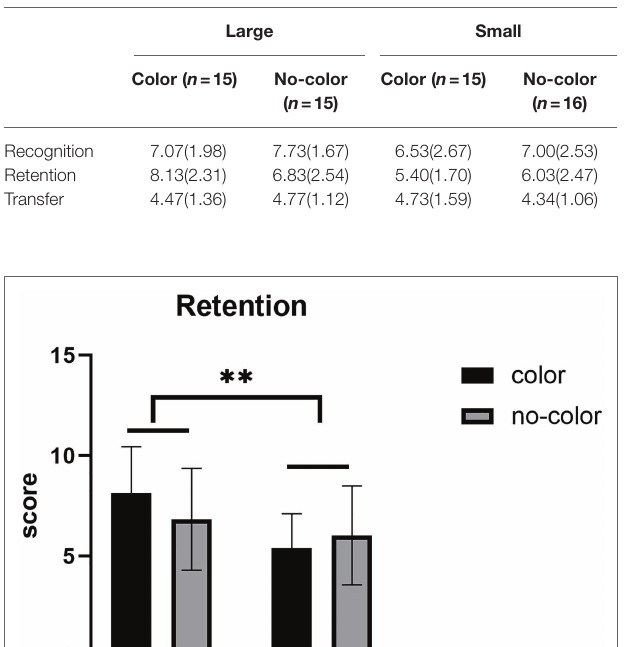
TABLE 1 | Scores for label sizes with and without color levels.